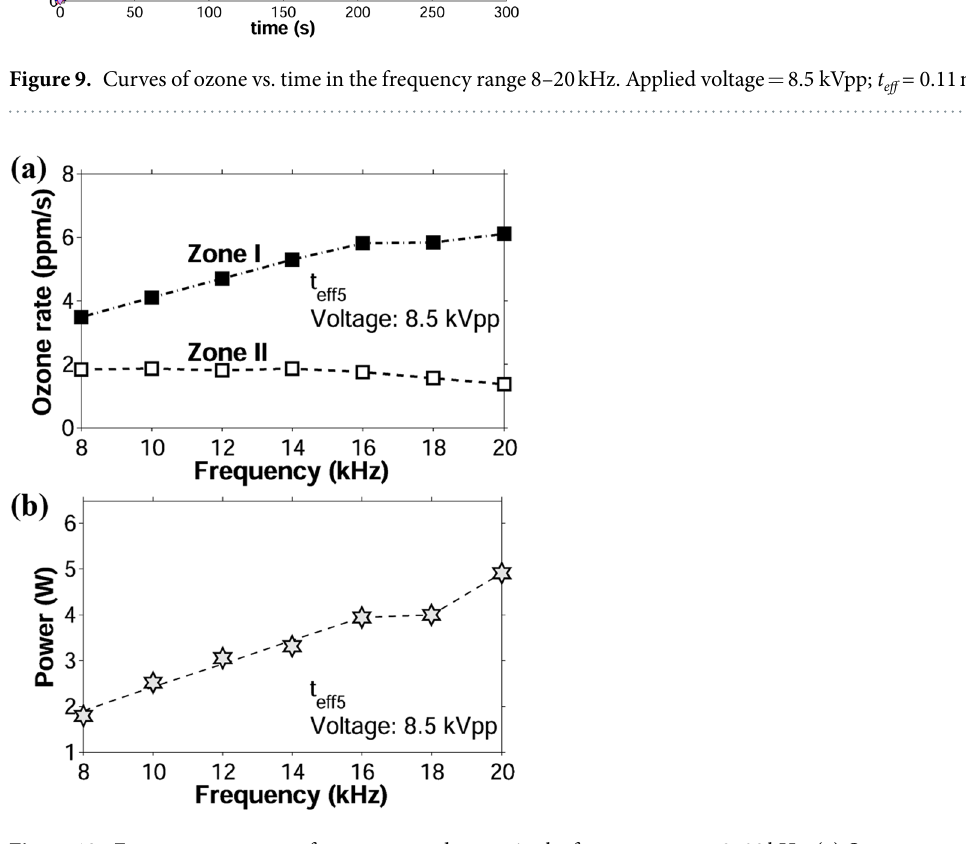
Figure 10. Frequency response of ozone rate and power in the frequency range 8–20 kHz. ( a ) Ozone rate vs. frequency. ( b ) Power vs. frequency. Applied voltage = 8.5 kVpp; t eff = 0.11 mm ( t eff 5